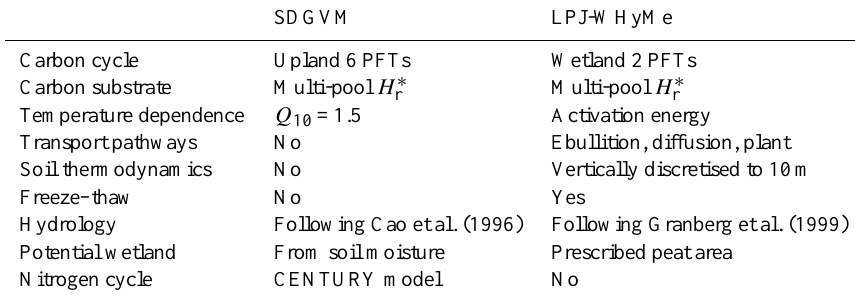
Table 2. Principal differences between LPJ-WHyMe and SDGVM relevant to the simulation of CH 4 emissions.